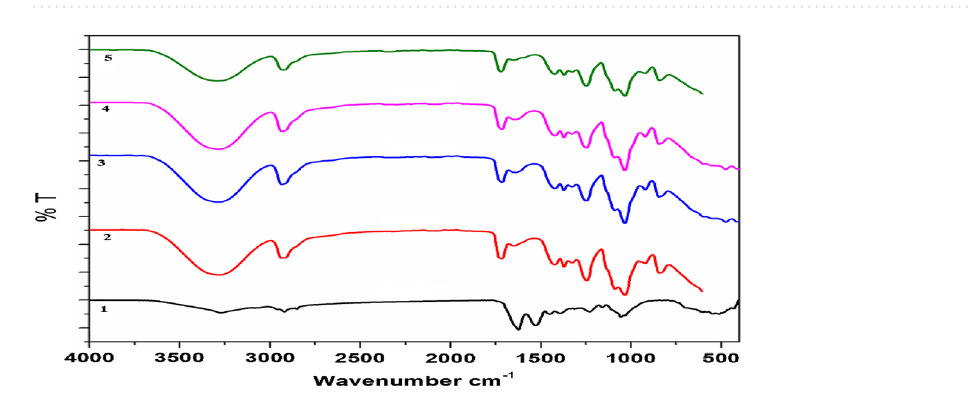
Figure 8. SEM micrographs of BC/PVA/Ch composite membranes loaded with CuO-NPs (0.025, 0.050, 0.075, and 0.100 mg in ( a , b , c , d , and e ), respectively). All images were taken with 20μm, original magnification of 5000 x, with applied voltage of 20 kV.